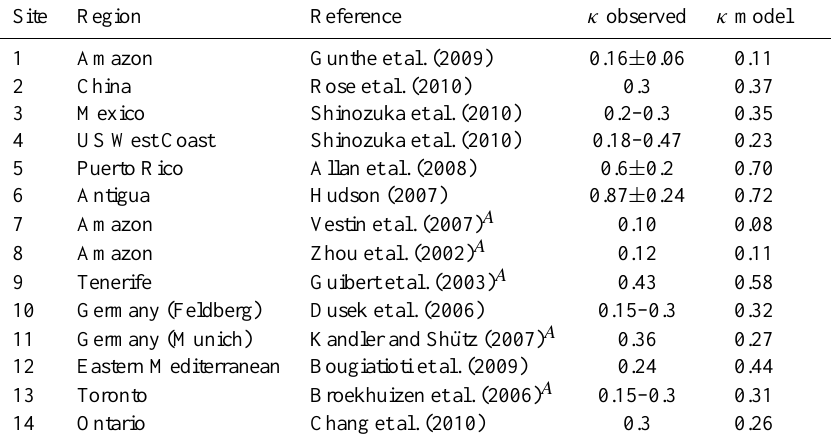
Table 2. Comparison between observed and modelled κ values. A κ calculated from reported aerosol soluble fraction, following Gunthe et al. (2009). Most measurement sites were surface campaigns, with the exception of Shinozuka et al. (2010) and Hudson (2007), which are flight data. For flight data an average altitude of approx. 1500 (m) was